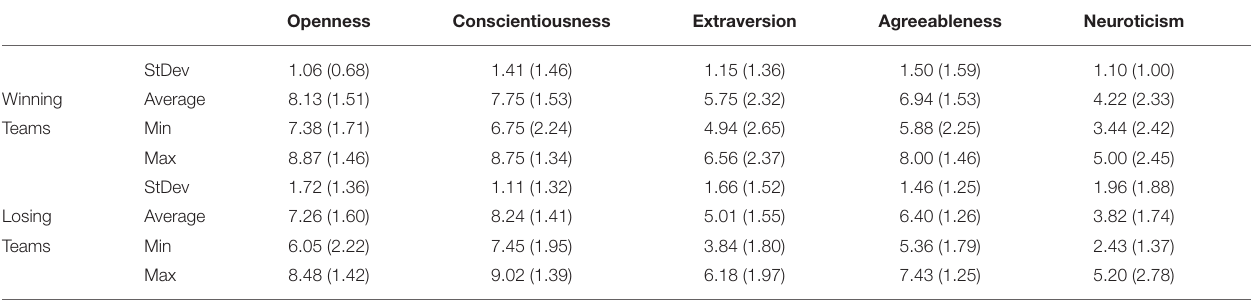
TABLE 5 | Mean (Stdev) of standard deviation, average, minimum, and maximum for personality traits for winning and losing teams.